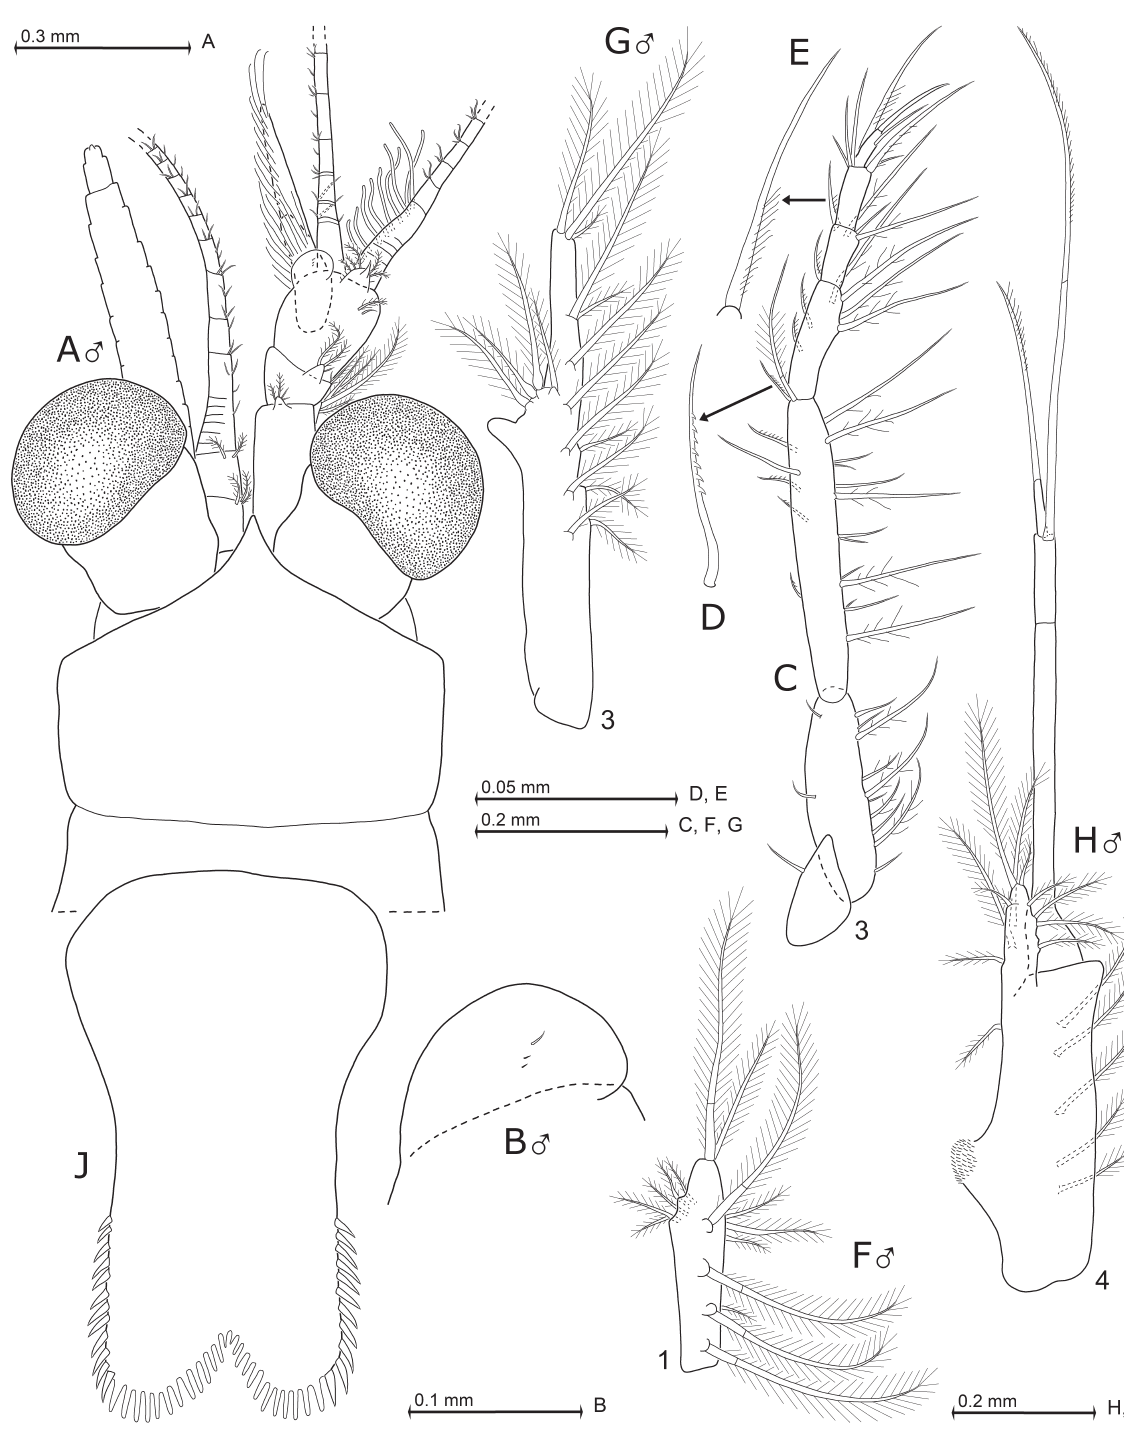
Fig. 9. Mysidium columbiae (Zimmer, 1915), lectotype from Cartagena in Colombia (A) and non-types from Curaçao (B–J). A . ♂, 4.4 mm body length. B, F–J . ♂, 6.1 mm. C–E . ♀, 5.5 mm. A . Cephalic region; left antennula and setae of antennal scale omitted. B . Mediodistal extension of right antennular trunk, dorsal view. C . Third thoracic endopod, caudal view. D – E . Details of panel (C) showing modified setae. F – G . Pleopods 1 and 3, rostral view. H . Pleopod 4, caudal view. J . Telson. Sample affiliation: Colombia - type locality (A), Curaçao